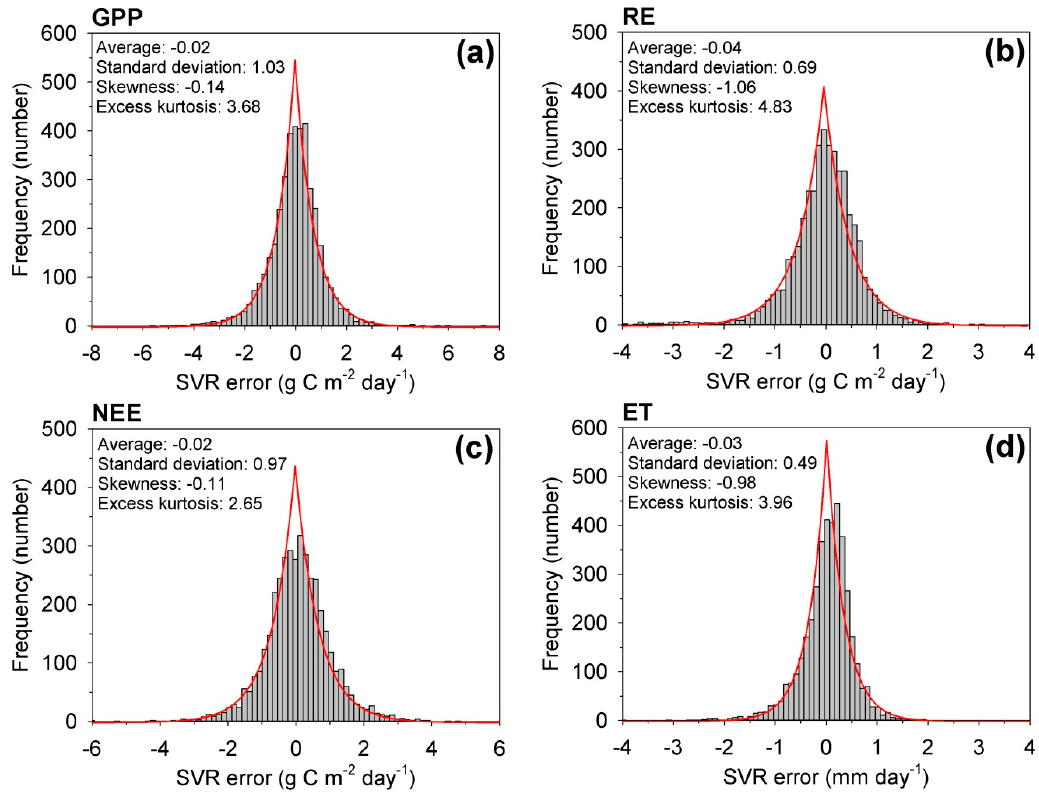
Figure 7. Histograms of the SVR model error for the fluxes, i.e., GPP ( a ), RE ( b ), NEE ( c ), and ET ( d ) over the entire study period. The solid red line represents a double-exponential distribution with the given average and standard deviation.